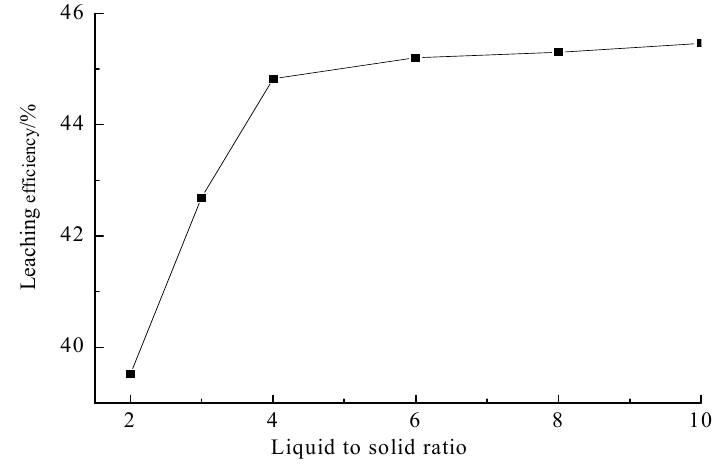
Figure 7. Effect of L/S on zinc extraction.